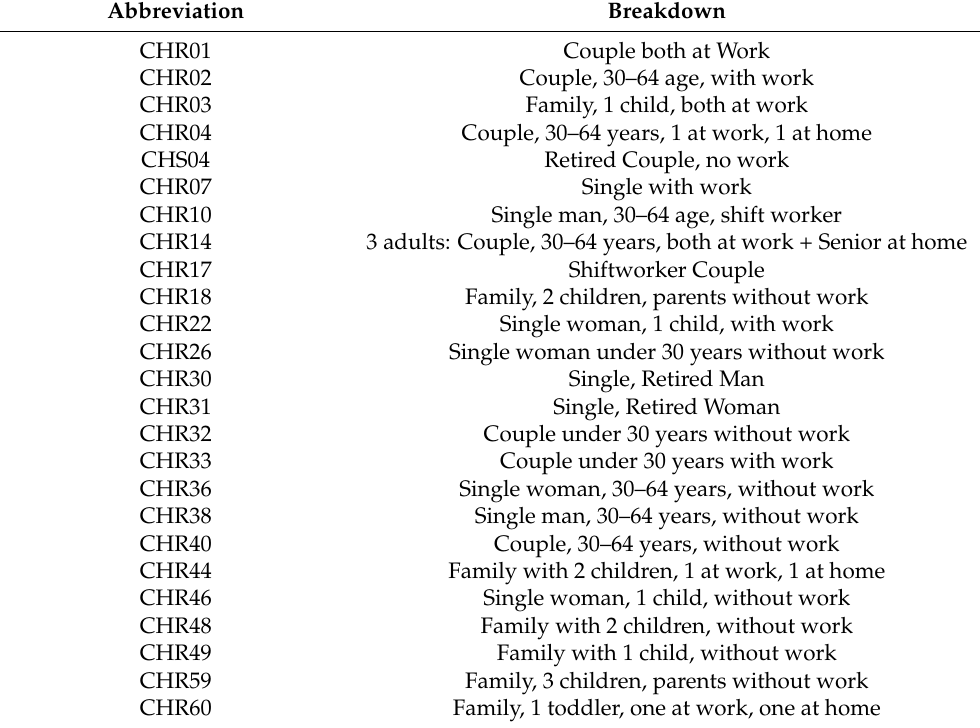
Table A2. Breakdown of Household Abbreviations.